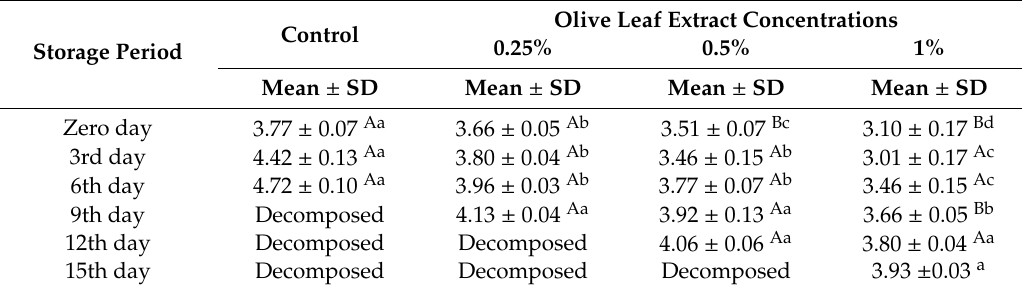
Table 9. The pattern of mold and yeast count (log10 cfu / g) in poultry meat treated with di ff erent concentrations of olive leaf extract during the chilling storage period at 4 ± 1 ◦ C (mean ± standard deviation